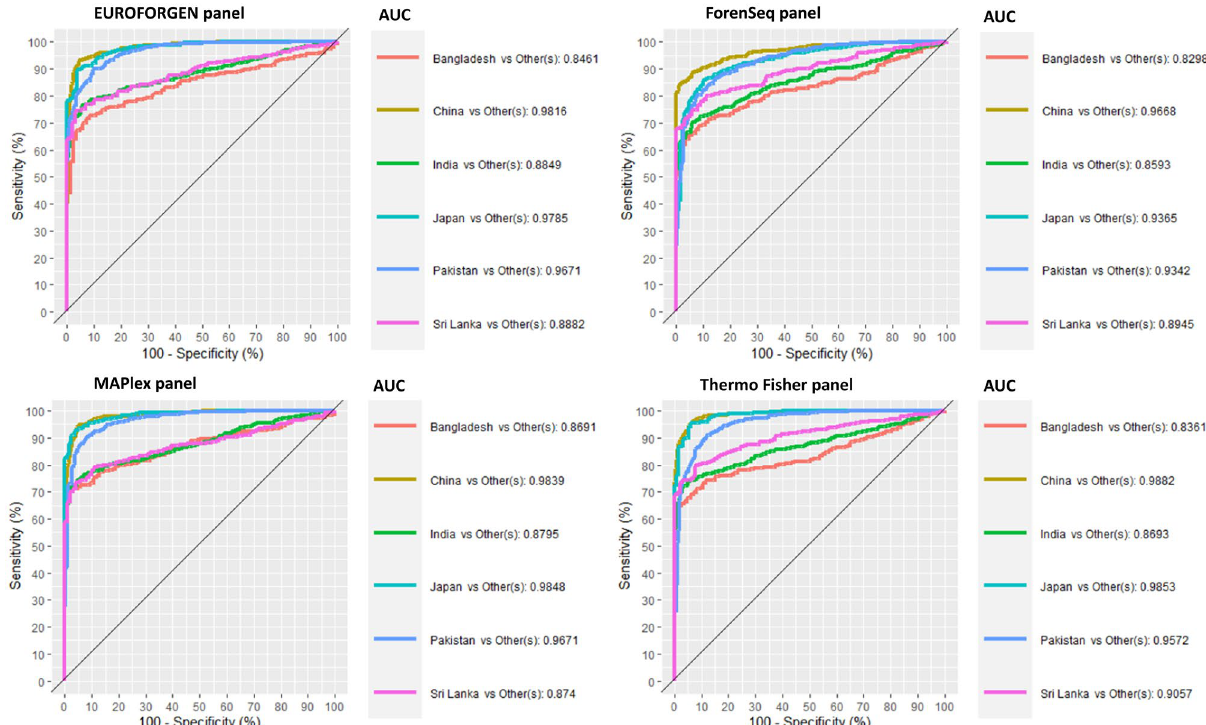
Figure 11. ROC curves, sensitivity, specificity, and AUC values for Asian countries and populations.